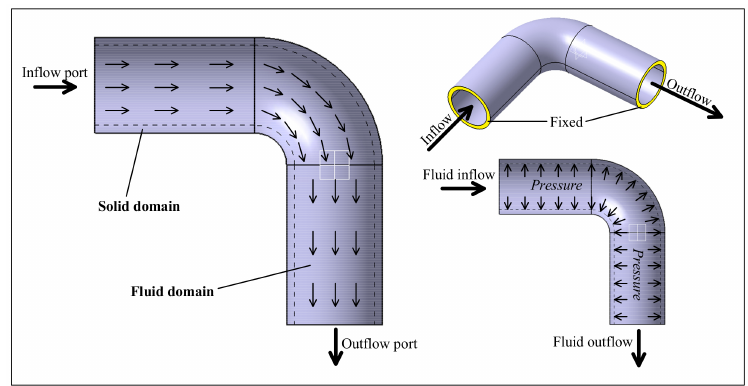
Figure 1. The structure and flow paths of copper bending